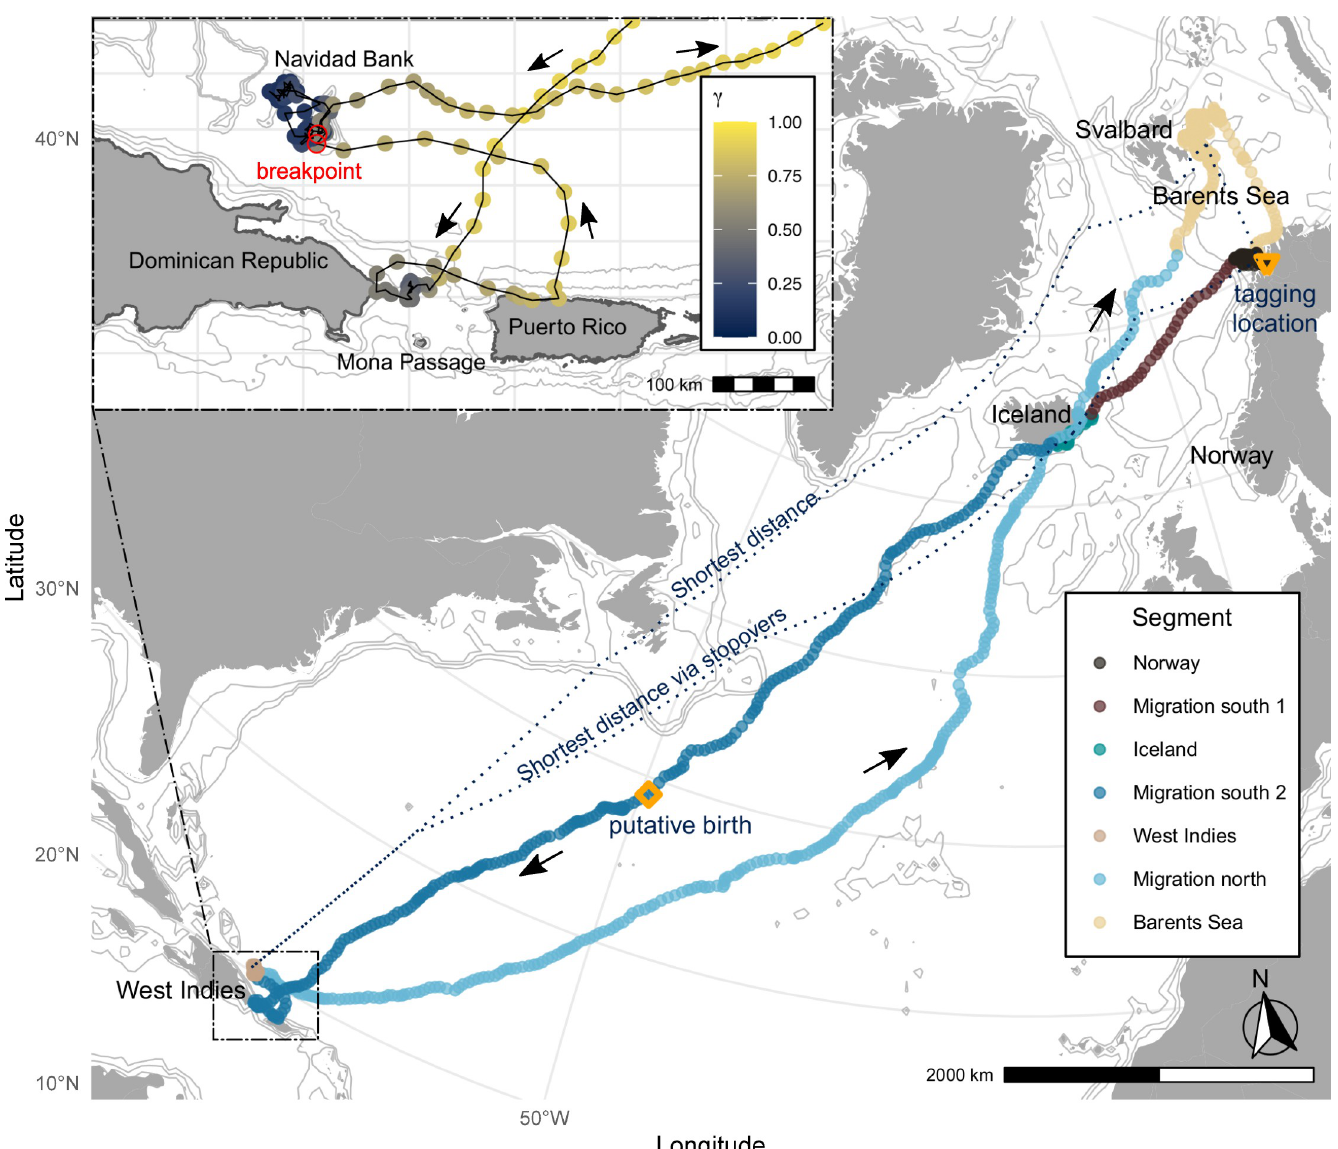
Fig 1. Full migration track of a pregnant female humpback whale in the Northeastern Atlantic. Locations from predicted path colored by the different migration segments. Tagging location is indicated by an orange triangle and the putative location of birth is indicated by an orange square. The inset shows movements on the breeding grounds, colored by movement persistence, yellow indicating directional travel, and blue indicating meandering movement. Arrows show the direction of movement. Dotted blue lines in the main map indicate the shortest possible distances through water. Contour lines show the 200 m, 1000 m, and 2000 m bathymetric isolines (data from [30] for the main map and [31] for the inset). Landmass data was obtained from